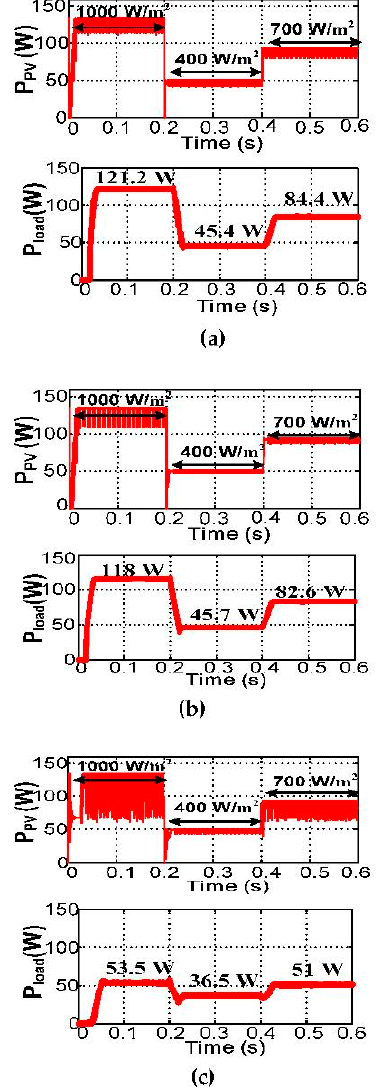
Figure 5. D1 PV power and average load power for: ( a ) 0.5 mH; ( b ) 1 mH; ( c ) 5 mH.